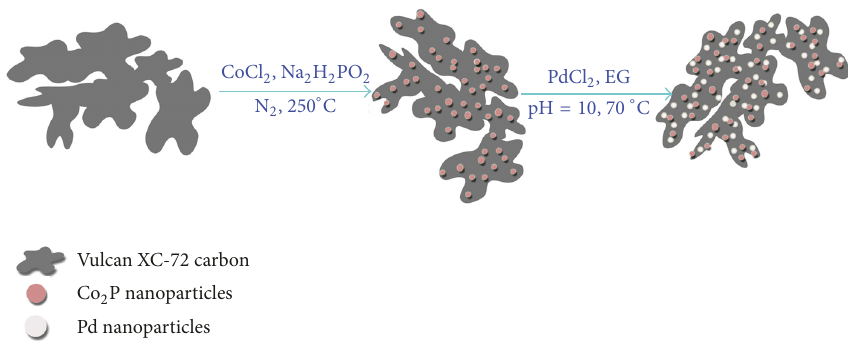
Figure 1: Synthesis procedure of Pd nanoparticle-modified C/Co 2 P